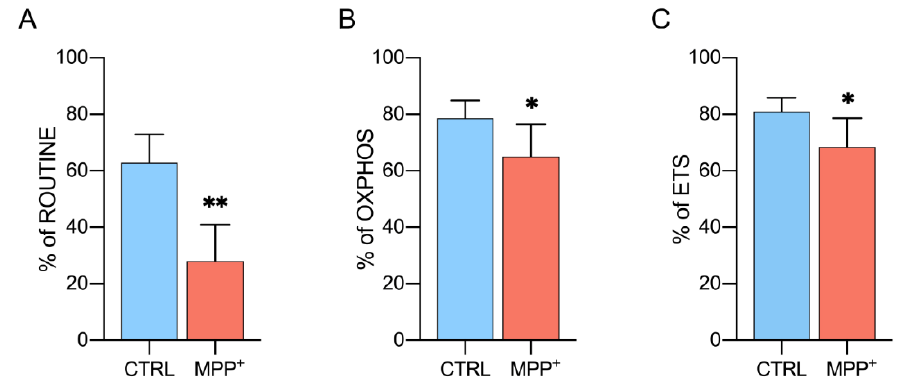
Figure 4. Coupling efficiency of different respiratory states. Rate of oxygen flux during ROUTINE ( A ), OXPHOS ( B ), and ETS ( C ) coupled with the ADP phosphorylation. Data are shown as the percentage of the reference state and expressed as means with standard deviation; * p < 0.05 and ** p < 0.01.